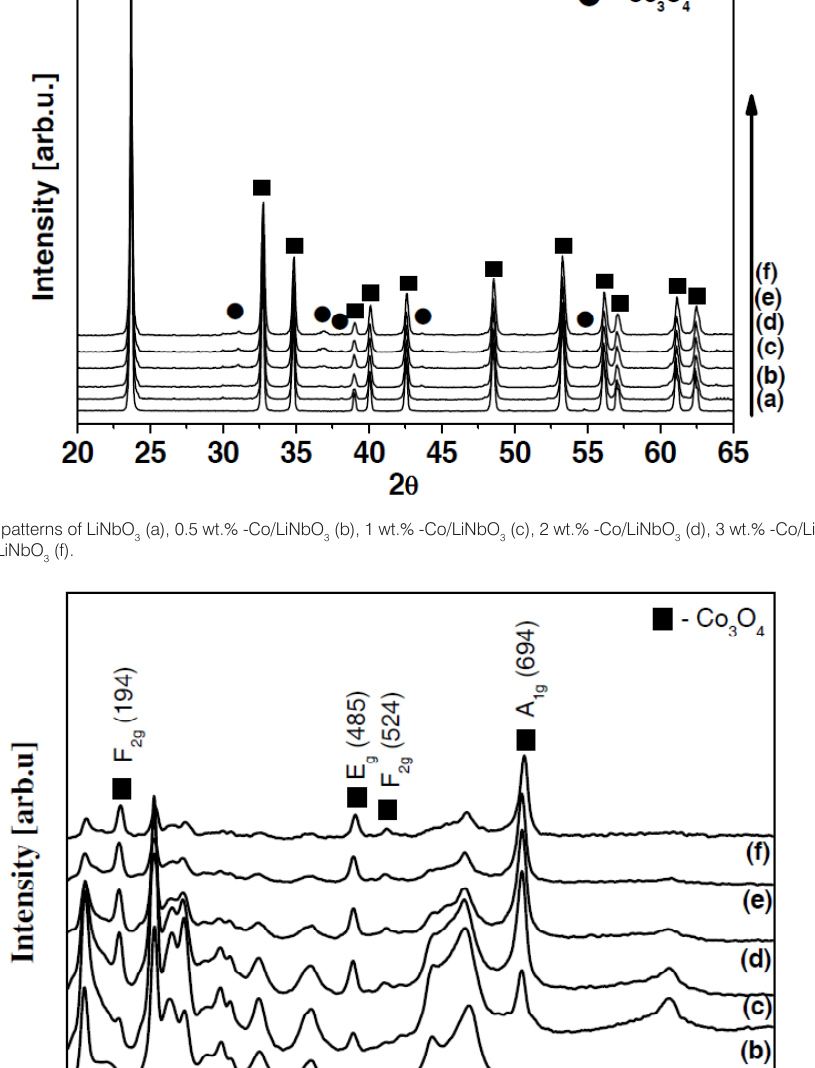
(a), 0.5 wt.% -Co/LiNbO 3 3